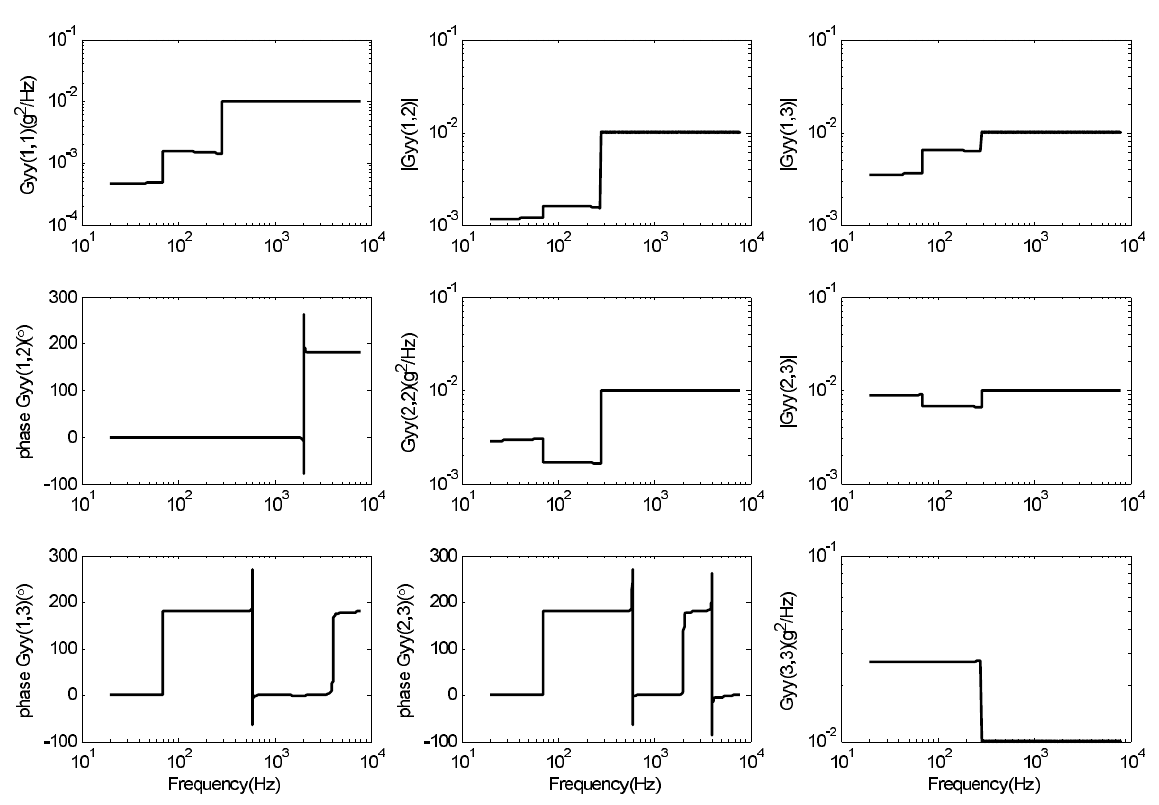
Fig. 21. Output cross spectral density matrix for the cantilever beam